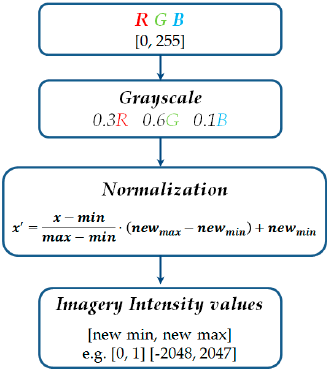
Figure 6. RGB to imagery intensity scale conversion scheme.